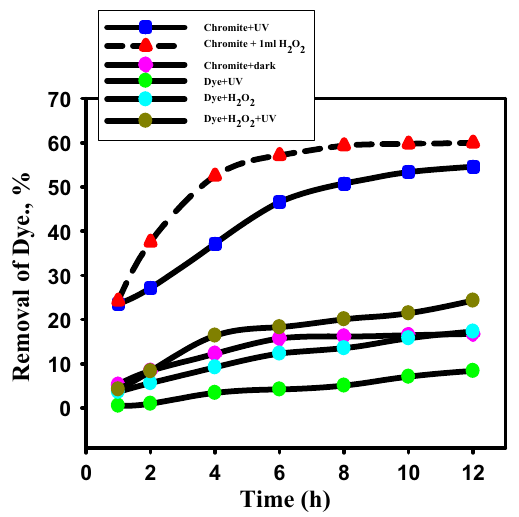
Fig. 3 Effect of illumination time on the removal of Congo red dye using chromite ? UV, chromite ? UV ? H 2 O 2 , chromite without UV or H 2 O 2 , UV only without chromite or H 2 O 2 , H 2 O 2 only without chromite or UV and UV ? H 2 O 2 without